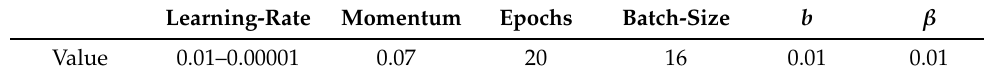
Table 1. Recommended hyperparameters.